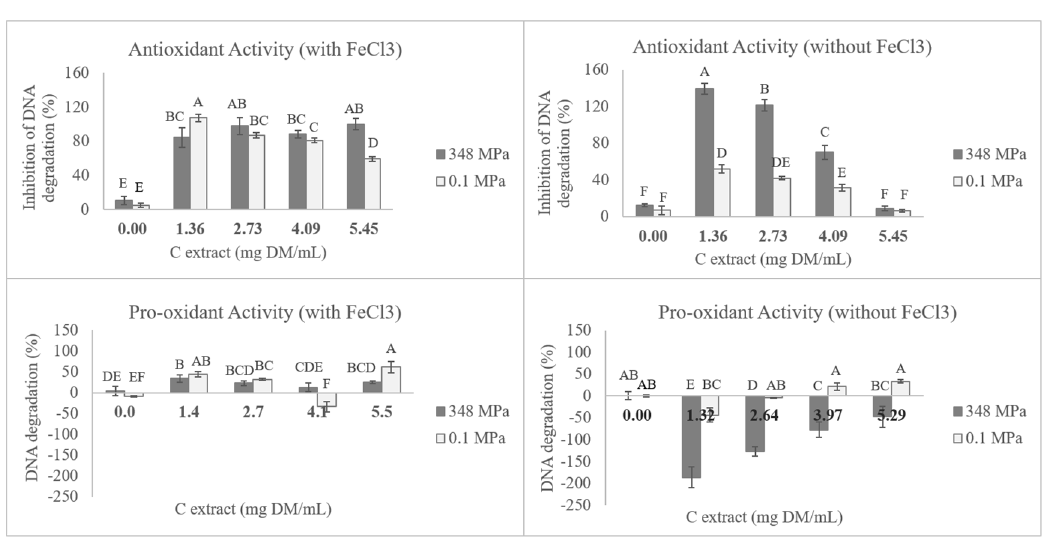
Figure 2. Antioxidant activity, i.e., prevention of DNA degradation (in an H 2 O 2 system or and H 2 O 2 /FeCl 3 system). Pro-oxidant activity (in the presence and absence of iron cations) for 35% ( v / v ) ethanol extracts (extracts S348/20/35 and S0.1/20/35). Different letters indicate significant differences ( p < 0.05) between extracts for each condition set.